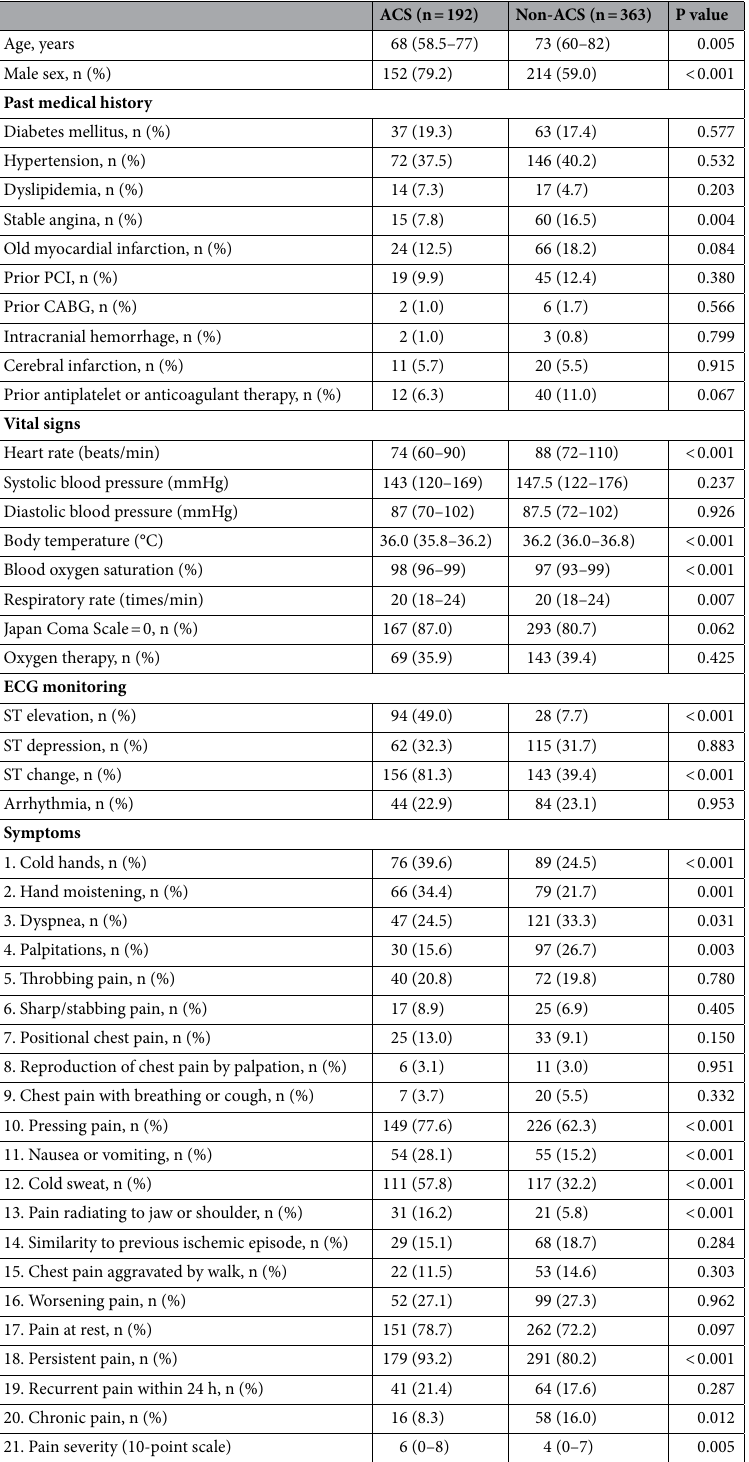
Table 1. Baseline characteristics and clinical outcomes in the internal cohort. Data are presented as median and interquartile range for continuous features. P- values were calculated using Pearson’s chi-square test or Mann–Whitney U test. CABG (coronary artery bypass grafting), ECG (electrocardiogram), PCI (percutaneous coronary